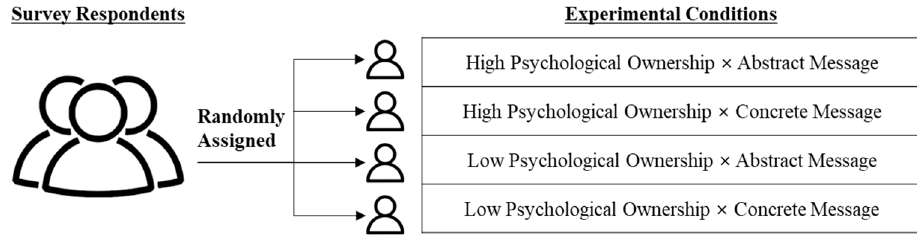
Figure 2. Random assignment to one of the experiment conditions